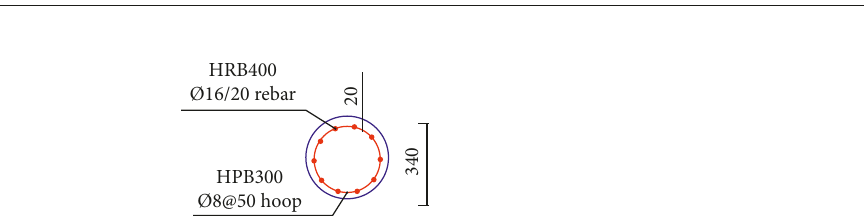
Figure 6: Longitudinal reinforcements and distributions of the specimens. Table 2: Basic parameters of the steel bars and concrete.